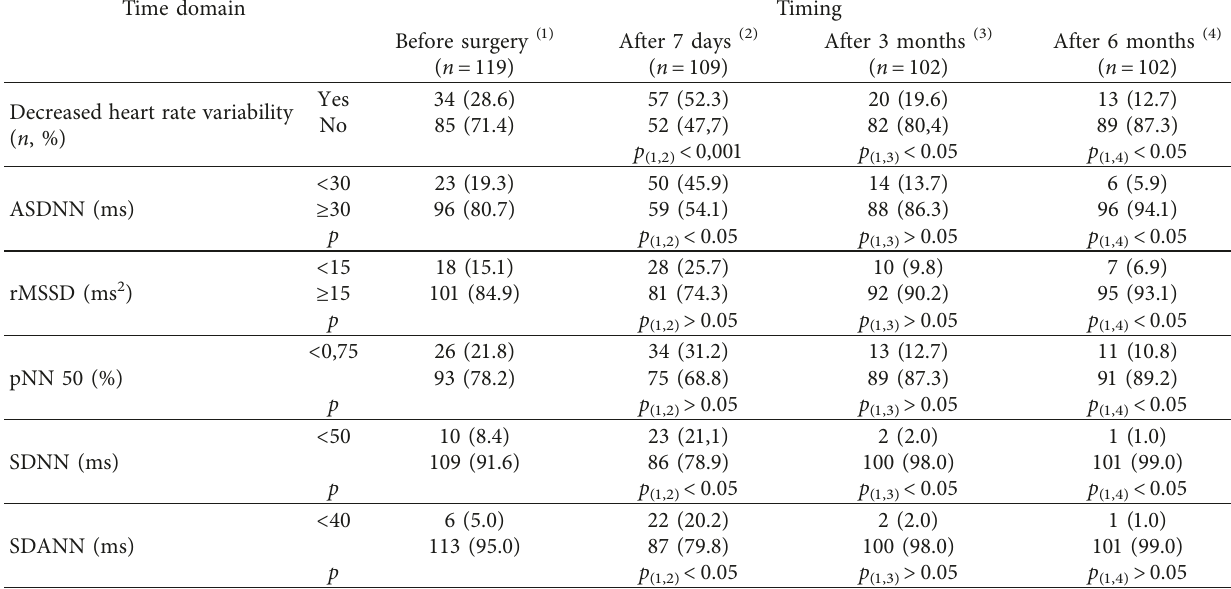
Table 4: Ratio of decreased heart rate variability before and after